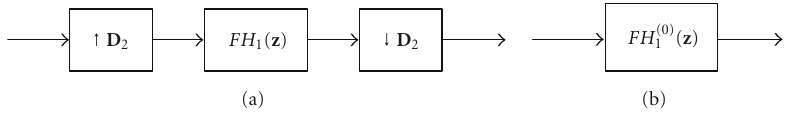
Figure 14: Equivalent block